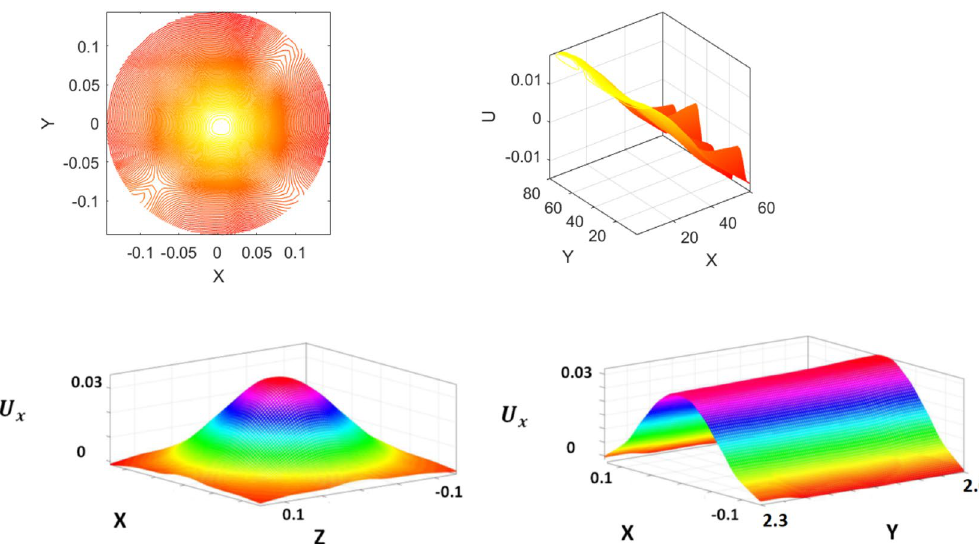
Figure 12. Prediction of liquid velocity for ANFIS model without using the CFD model, machine learning overview. X, Y, and Z represent computing nodes or position of numerical elements in the bubble column